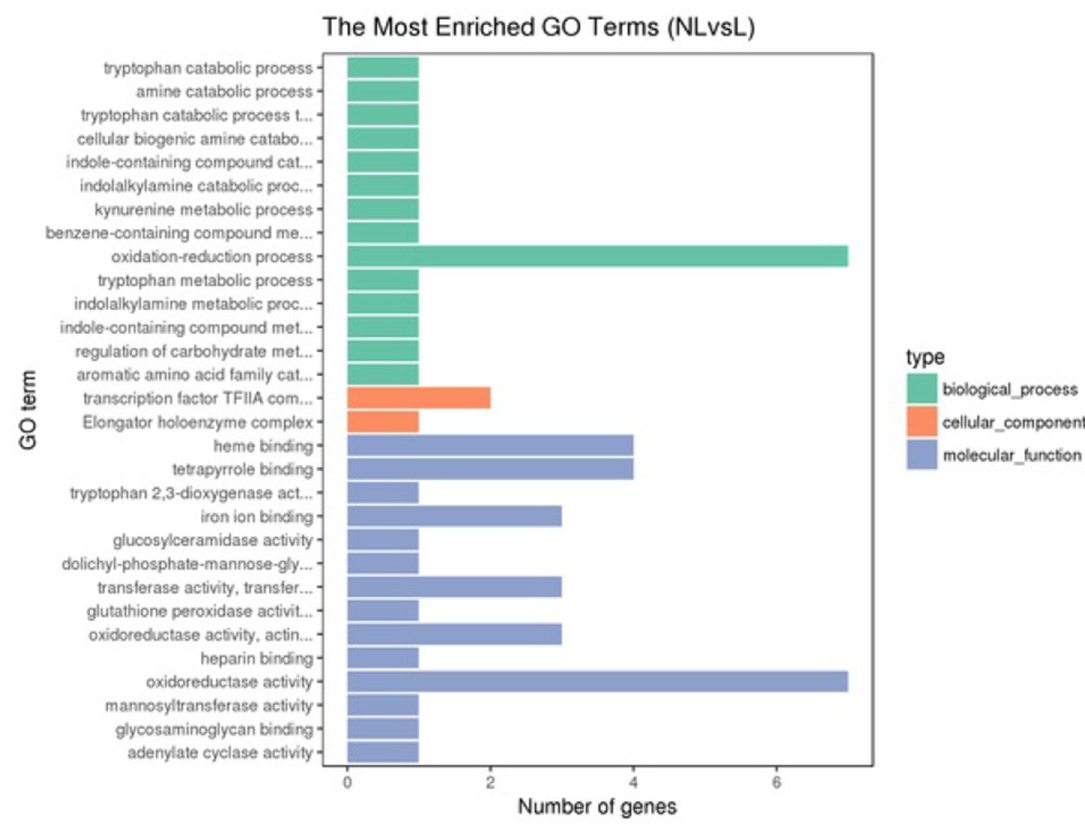
Fig 4. Gene ontology functional classification.